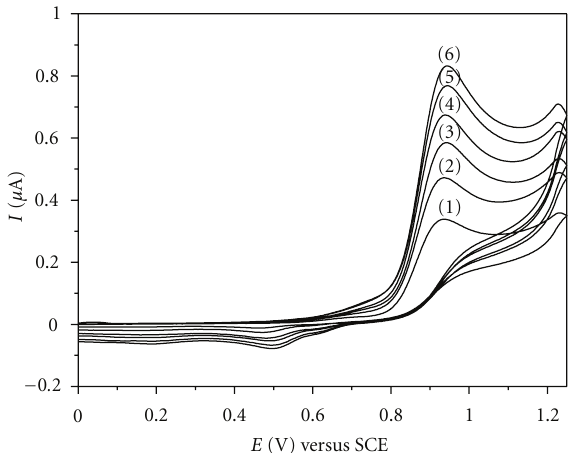
Figure 1: Cyclic voltammograms of 0.03mM ASA. Supporting electrolyte: 0.1M Na 2 SO 4 pH 7; starting potential: 0 V versus SCE; potential range: 0V → +1.25V → 0V versus SCE; scan rate: 0.03Vs − 1 ; (1)–(3): scan 1–scan 3.